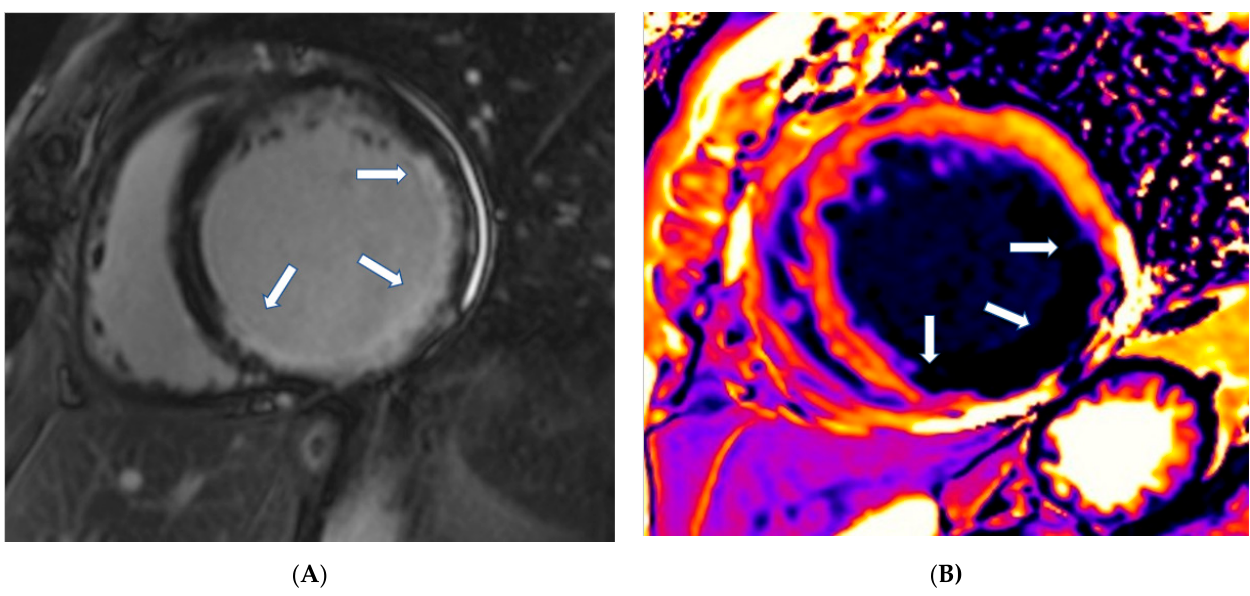
Figure 1. ( A ) Short-axis LGE image showing myocardial infarction (arrows) in the inferolateral wall of LV. ( B ) Matching native T1 mapping of the same patient.